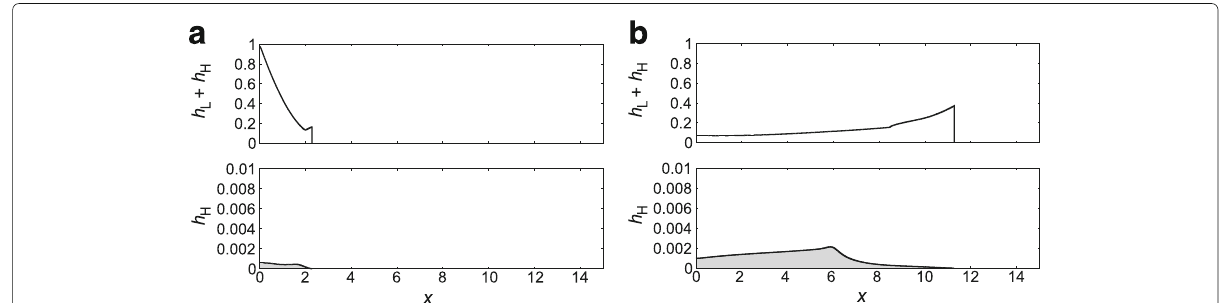
/ρ = 600.6) is calculated using the AB model with a H